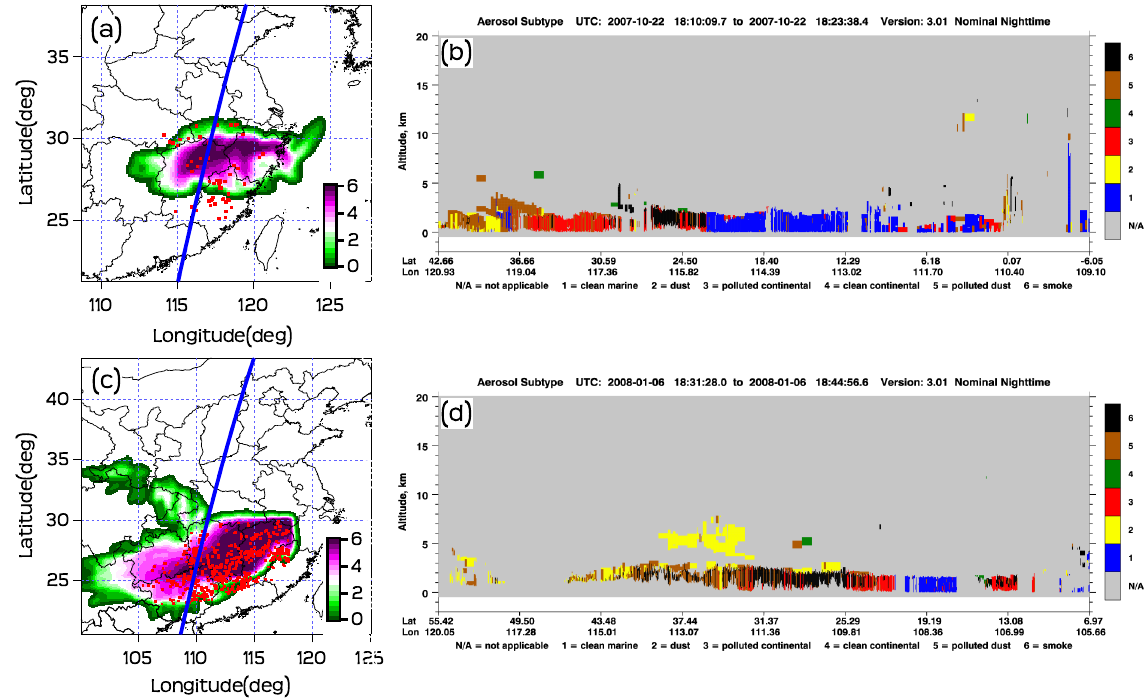
Fig. 6. Footprint regions of air masses and hotspots detected by MODIS satellite for open-burning events. Left panels indicate the spatial distribution of hotspots (red cross), air mass footprint region (shading color is in unit of natural logarithm of residence hour in each grid), and orbit of CALIPSO satellite (blue line); Right panels show the vertical profile of aerosol types along the CALIPSO satellite orbit, Black color blocks indicate the “smoke” aerosols are presented. (a) ∼ (b) for Case 1, and (c) ∼ (d) for Case